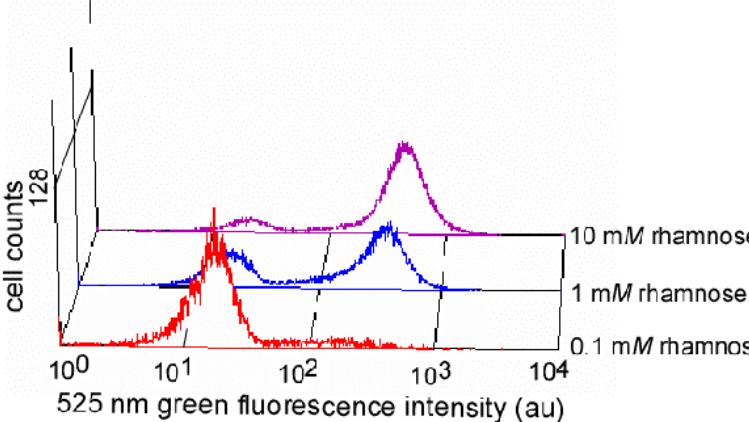
Fig. 5. Single-cell profiling of PhoB activation by ArcB with differing L-rhamnose concentrations. E . coli BW32405 (like BW26910, except phoAp - gfp rhaBp-arcB ∆ arcA ∆ ( ackA pta )) was grown in 1 % glycerol MOPS medium with 0.1, 1, and 10 m M L-rhamnose for 10 hours from a low cell density. Cultures were sampled for green fluorescence by flow cytometry at cell about density A 410